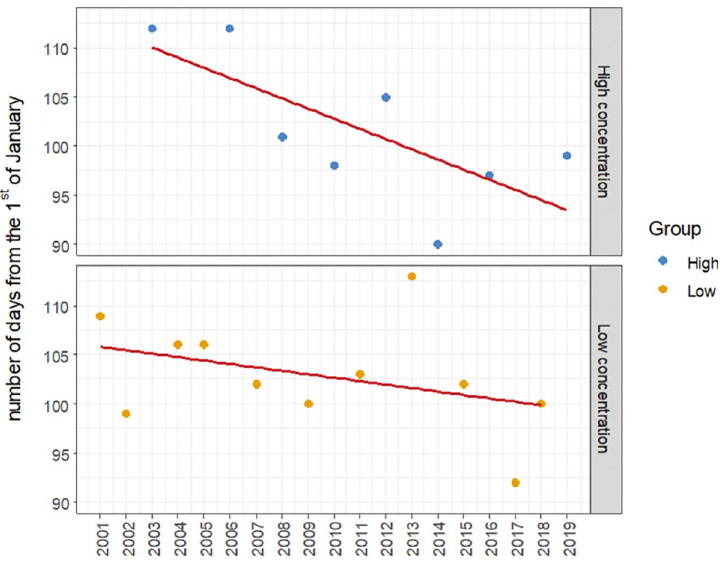
Fig 6. The scatterplot with linear regression line for high concentration (H) and low concentration (L) of Betula pollen in atmospheric